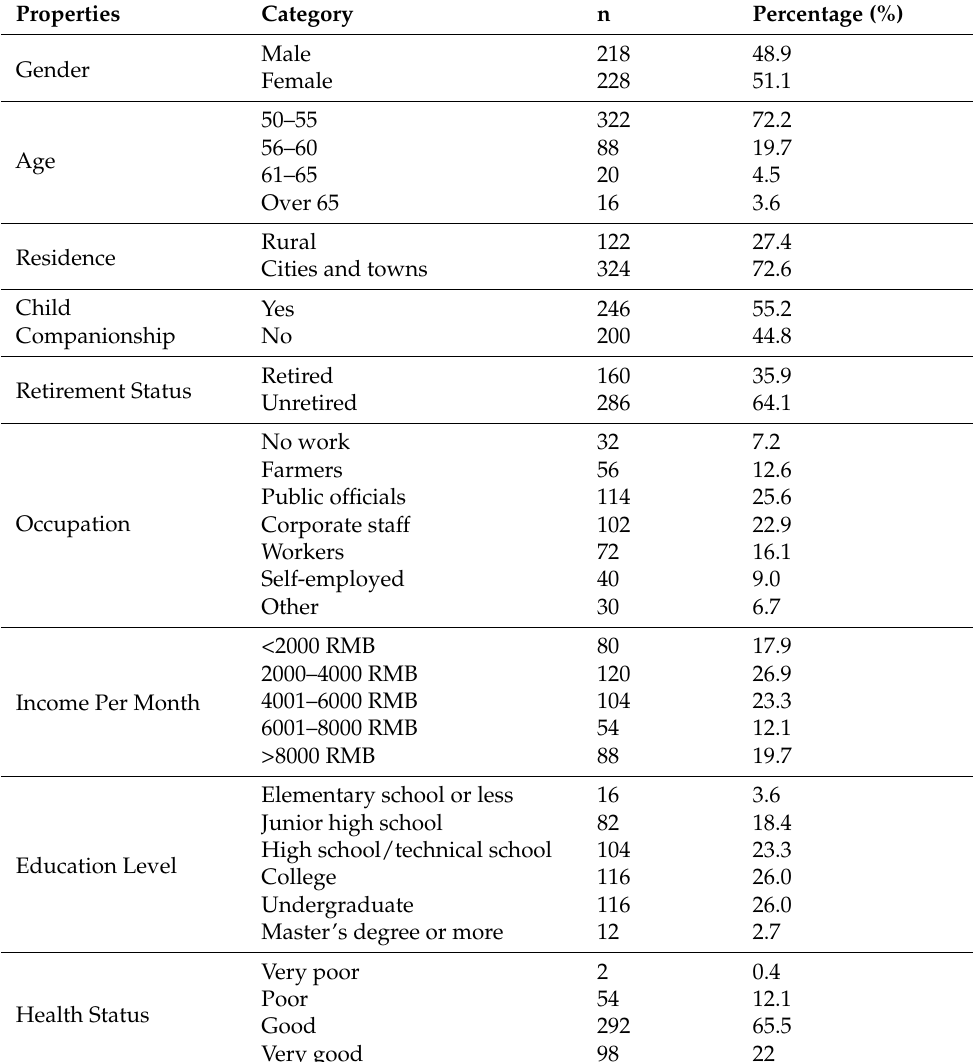
Table 1. Descriptive statistical results of samples ( N =